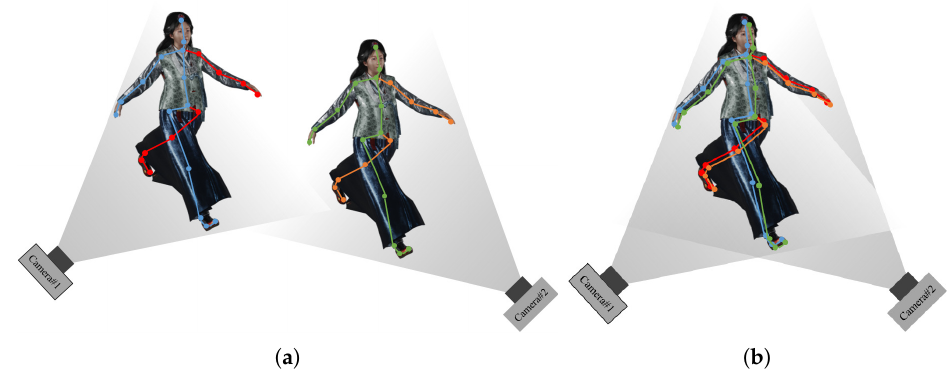
Figure 3. Initial parameter generation through joint set selection and primary joint alignment ( a ) before calibration, ( b ) after